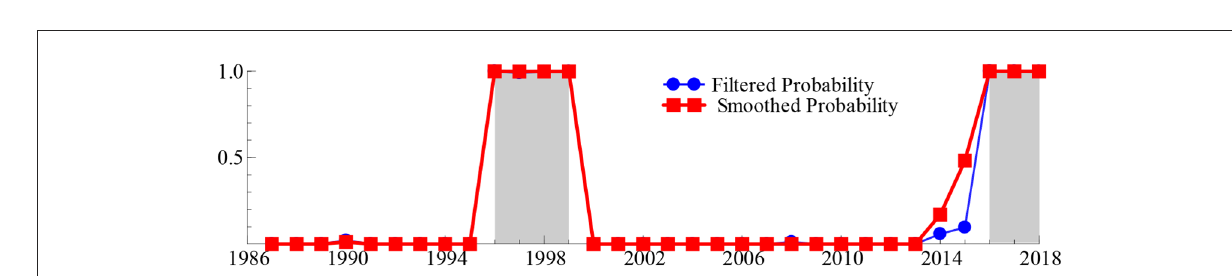
FIGURE3 The smooth probability time dynamic path of the low-growth regime.